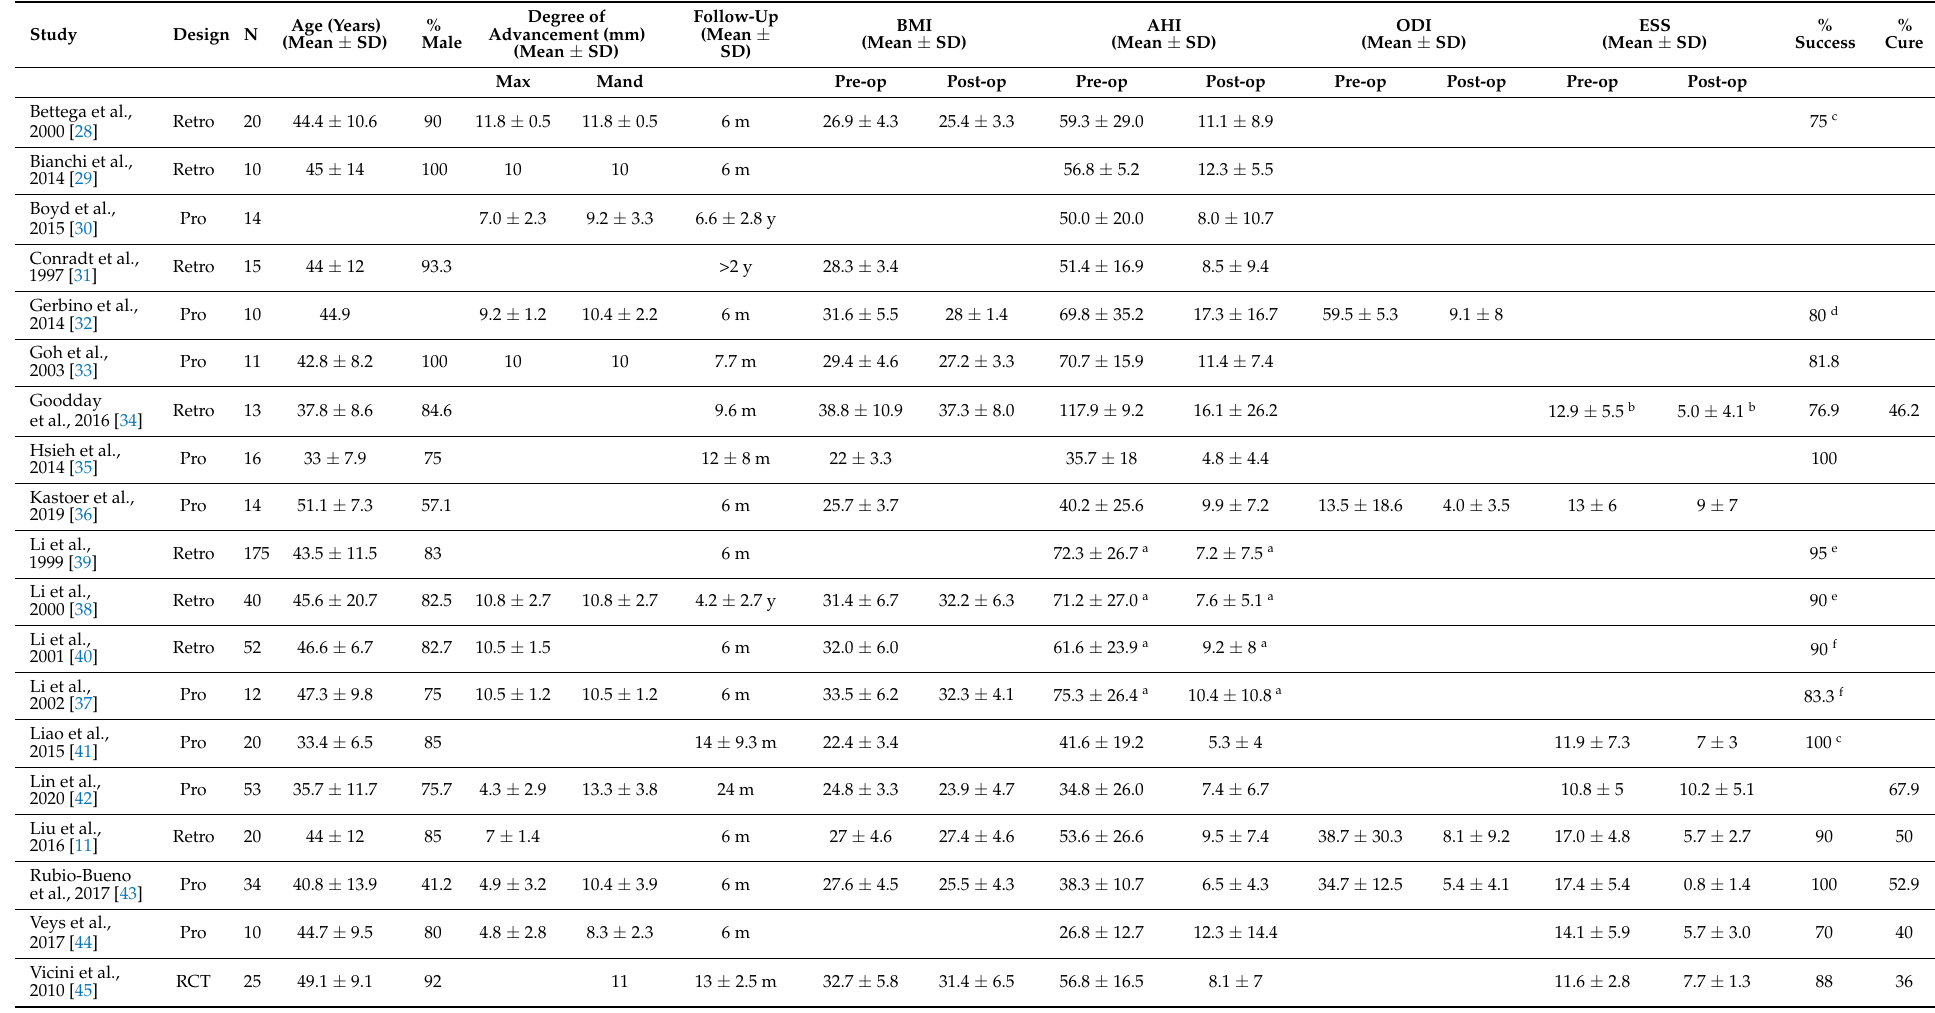
Table 1. Characteristics of studies on maxillomandibular